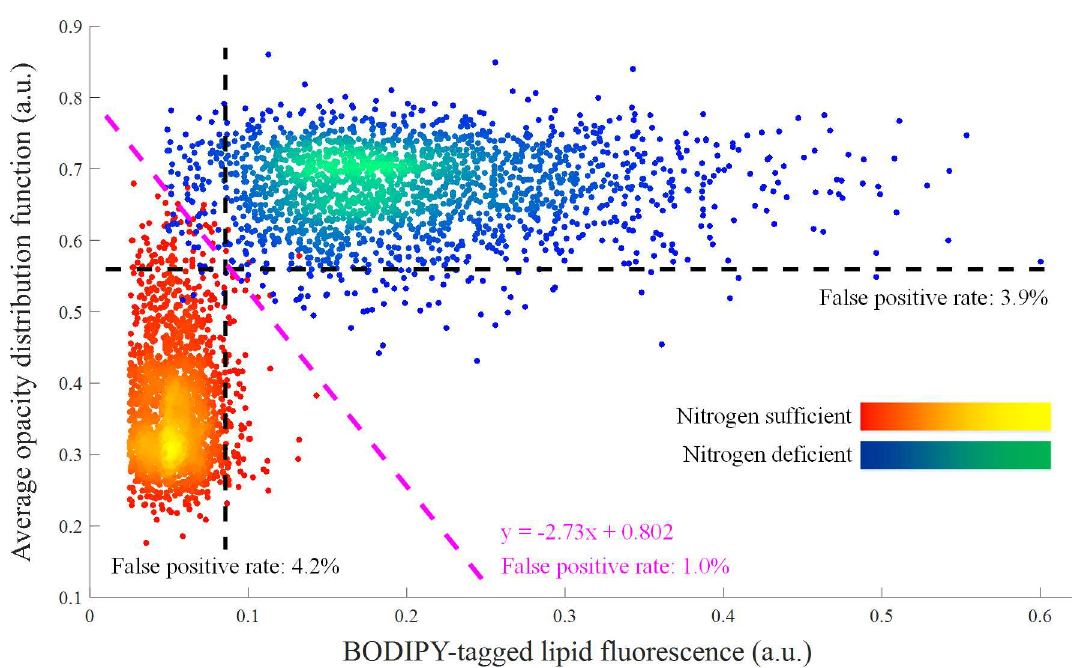
Fig 5. Combined scatter plot of the differently cultured E. gracilis cells in BODIPY-tagged lipid fluorescence signal strength and average opacity distribution function value (N = 2,000 for each culture). It is evident that the two culture groups can be separated more clearly with the two parameters than with either parameter alone, resulting in an improved false positive rate of 1.0%.